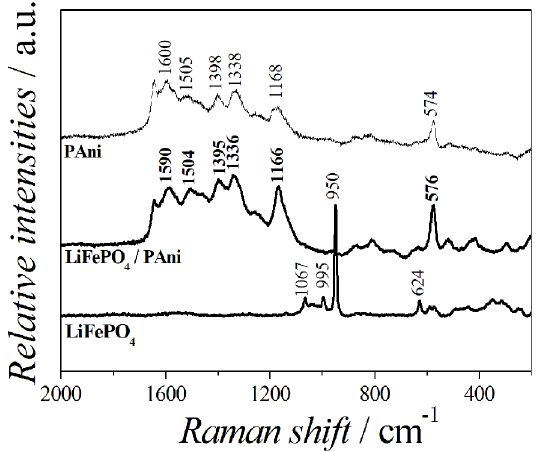
, PAni and LiFePO 4